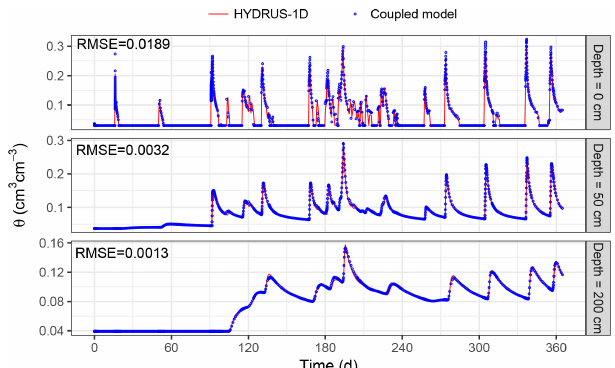
Figure 8. Comparison of soil moisture content at z = 0, 50, and 200cm for the layered soil column with rapidly changing upper boundary conditions (scenario 2, case 1). Taking the HYDRUS-1D solution as the truth, RMSEs of solution of the developed model are provided at different soil